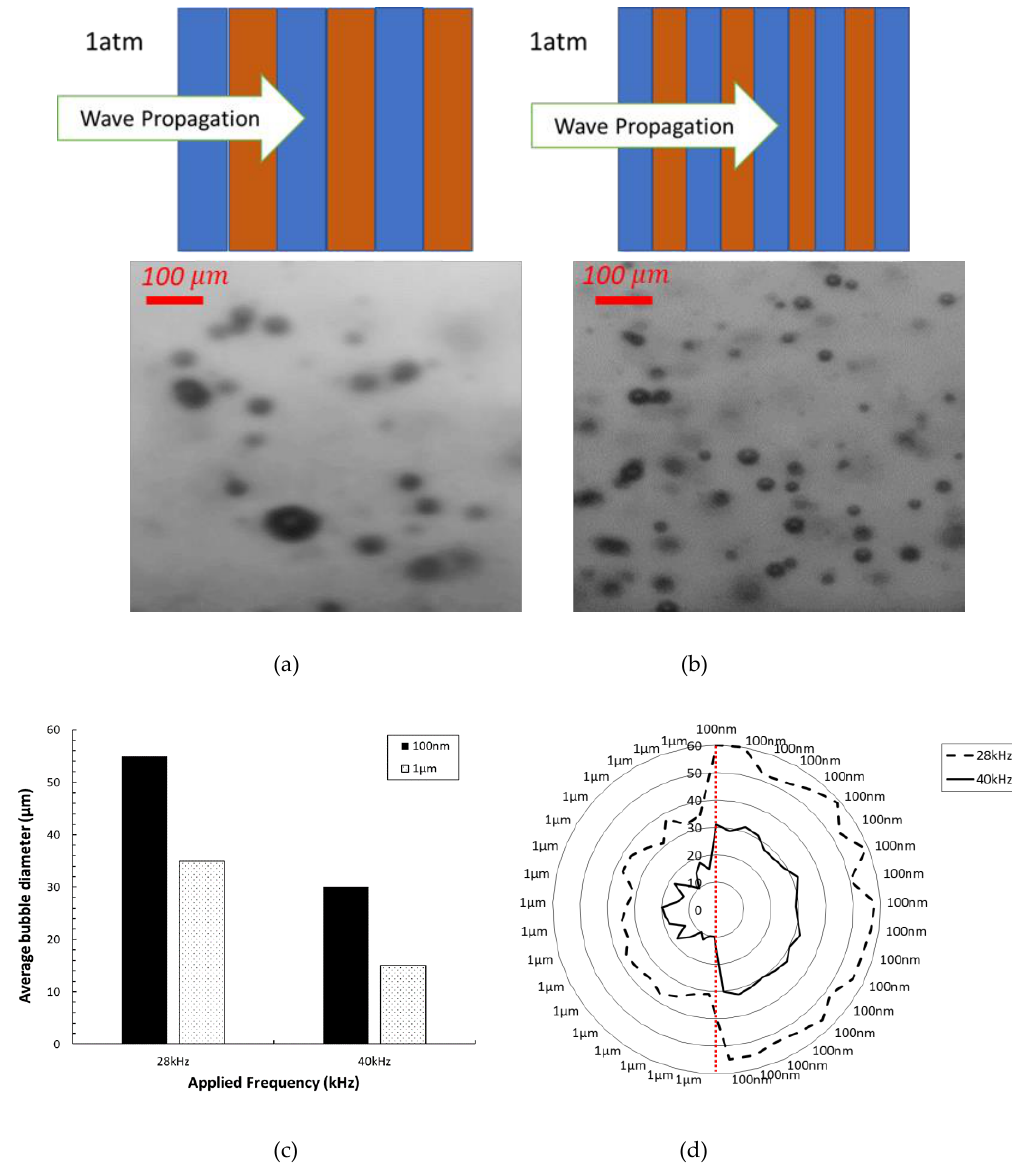
Figure 11. The bubbles with different shape and quantity on the surface with Ra=1µm under the effect of different applied frequencies ( a ) Bubbles occurrence at 28 kHz; ( b ) Bubbles occurrence at 40 kHz. ( c ) Average bubble diameters at different acoustic field frequencies and surface roughness parameters ( d ) distribution of the nucleated bubbles at different acoustic field frequency and surface roughness parameter.